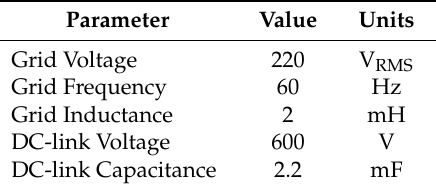
Table 1. Simulation Parameters.